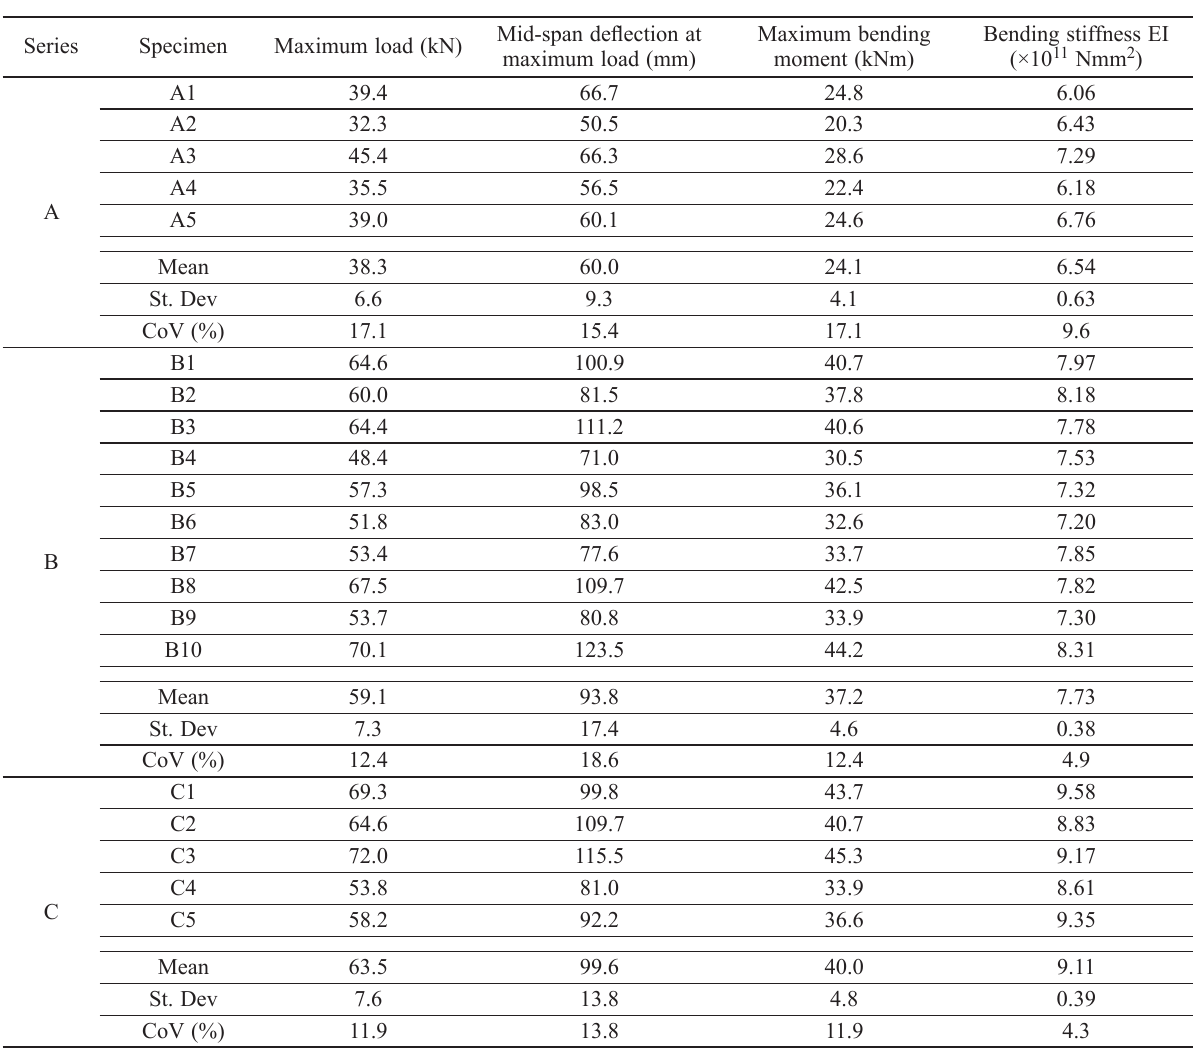
Table 5. Experimental results from bending tests